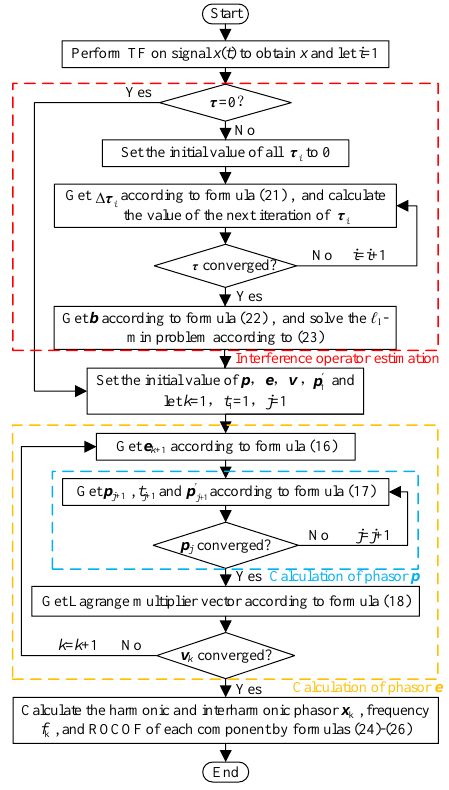
Figure 1. Analysis steps of the FMA for WFDS.